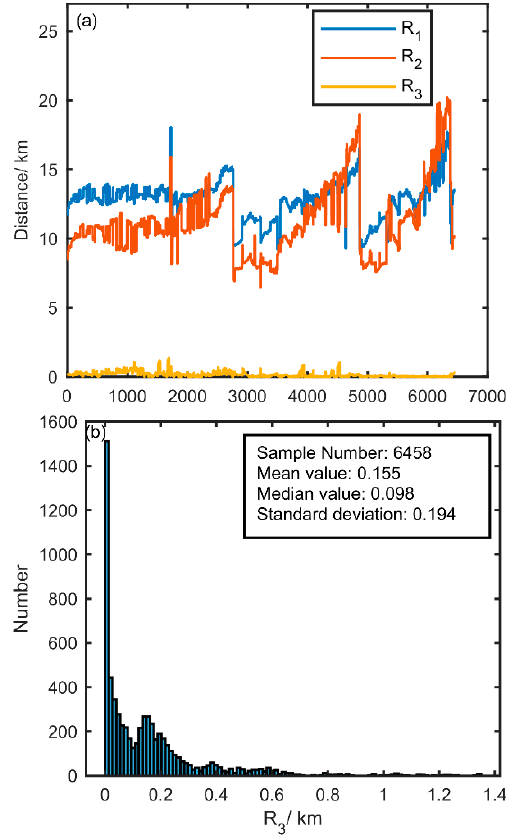
Figure 6. R 1 , R 2 and R 3 corresponding to the locating result. ( a ) Values of R 1 , R 2 , and R 3 versus the positioning result serial number; ( b ) Statistical results of R 3 .